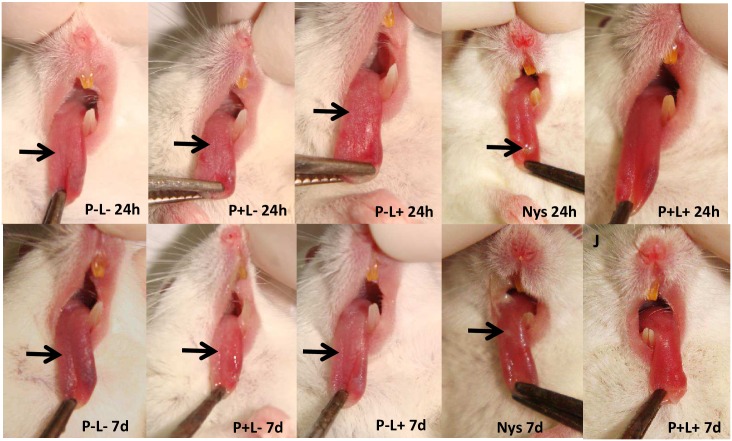
Representative images of white patches or pseudomembrane (arrow) on the dorsum of the tongue of animals from groups P-L-, P+L-, P-L+ and NYS and absence of tongue lesions of the animals submitted to the aPDT (P+L+), 24 hours (24h) and 7 days (7d) after treatment.